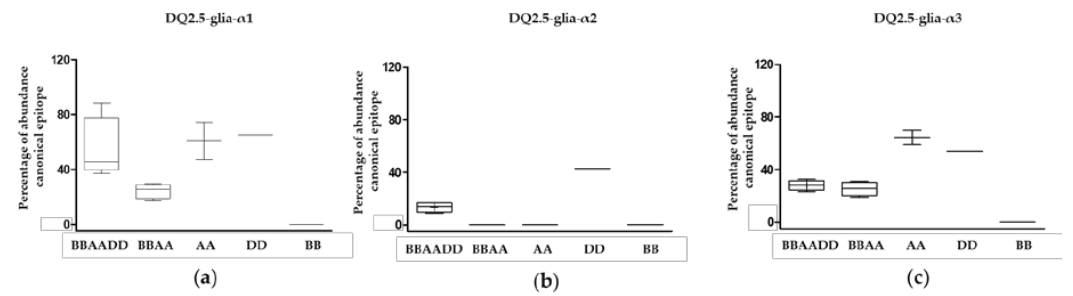
Figure 3. Abundance of CD canonical epitope and variants per wheat genome type. ( a ) Abundance of the canonical epitope DQ2.5-glia- α 1 and variants, ( b ) abundance of the canonical DQ2.5-glia- α 2 epitope and variants, and ( c ) abundance of the canonical DQ2.5-glia- α 3 epitope and variants. BBAADD: hexaploid genome; BBAA: tetraploid genome; AA, DD, and BB: diploid